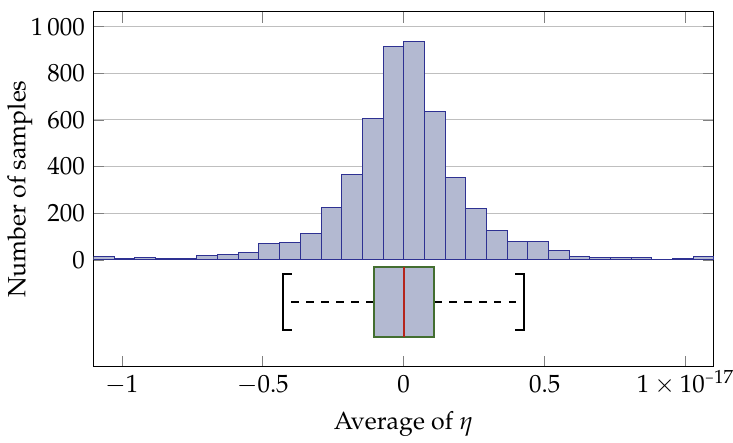
Figure 2. Mean values of the time series of the 5000 sampled spectra for the